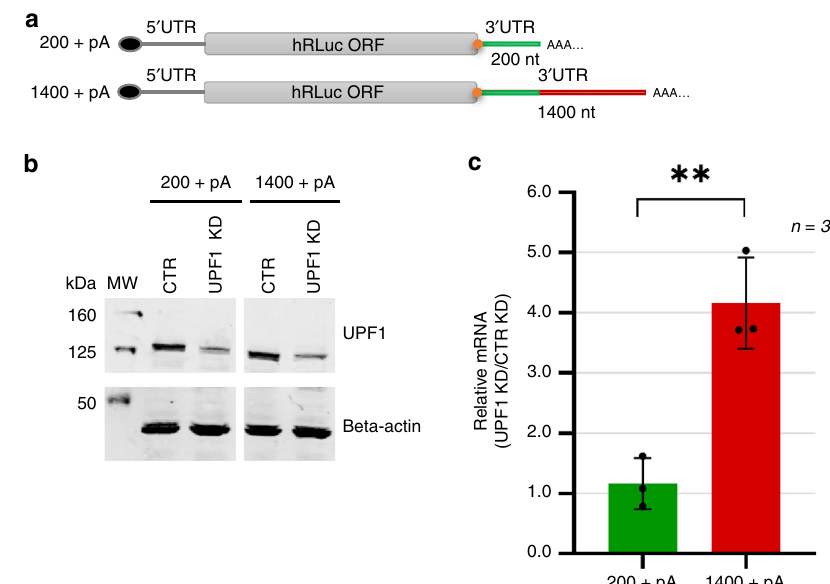
Fig. 4 Extension of the 3 ′ UTR renders the Rluc reporter mRNA NMD-sensitive in vivo. a Schematic representation of Rluc reporter constructs with either a 200 nts long (200 + pA) or a 1400 nt-long 3 ′ UTR (1400 + pA), modi fi ed for expression in human cells. The fi rst 200 nts of the 3 ′ UTR (green line) are identical in both constructs, the additional 1200 nts (red line) of the 1400 + pA 3 ′ UTR correspond to a head-to-tail duplicated sequence originating from the ampicillin resistance gene. The constructs were cloned into pcDNA3.1( − ) expression plasmid, where their expression is controlled by a CMV promoter and a bovine growth hormone polyadenylation signal. b Western blot analysis to monitor UPF1 knockdown ef fi cacy in HeLa cells transiently expressing either 200 + pA or 1400 + pA Rluc reporter mRNA. Cell lysates equivalent to 2 × 10 5 cells were loaded on a 10% SDS-PAGE, transferred onto a nitrocellulose membrane and probed for UPF1 and beta-actin. c Relative abundance of 200 + pA and 1400 + pA mRNAs in cells depleted for UPF1 (UPF1 KD) normalized to cells with a control knockdown (CTR KD) were measured by RT-qPCR. Mean values± standard deviations of 3 biological replicates are shown, values of the individual experiments are indicated by dots. (Unpaired, two-sided statistical t -test: 1400 + pA vs 200 + pA p value: 0.0039).